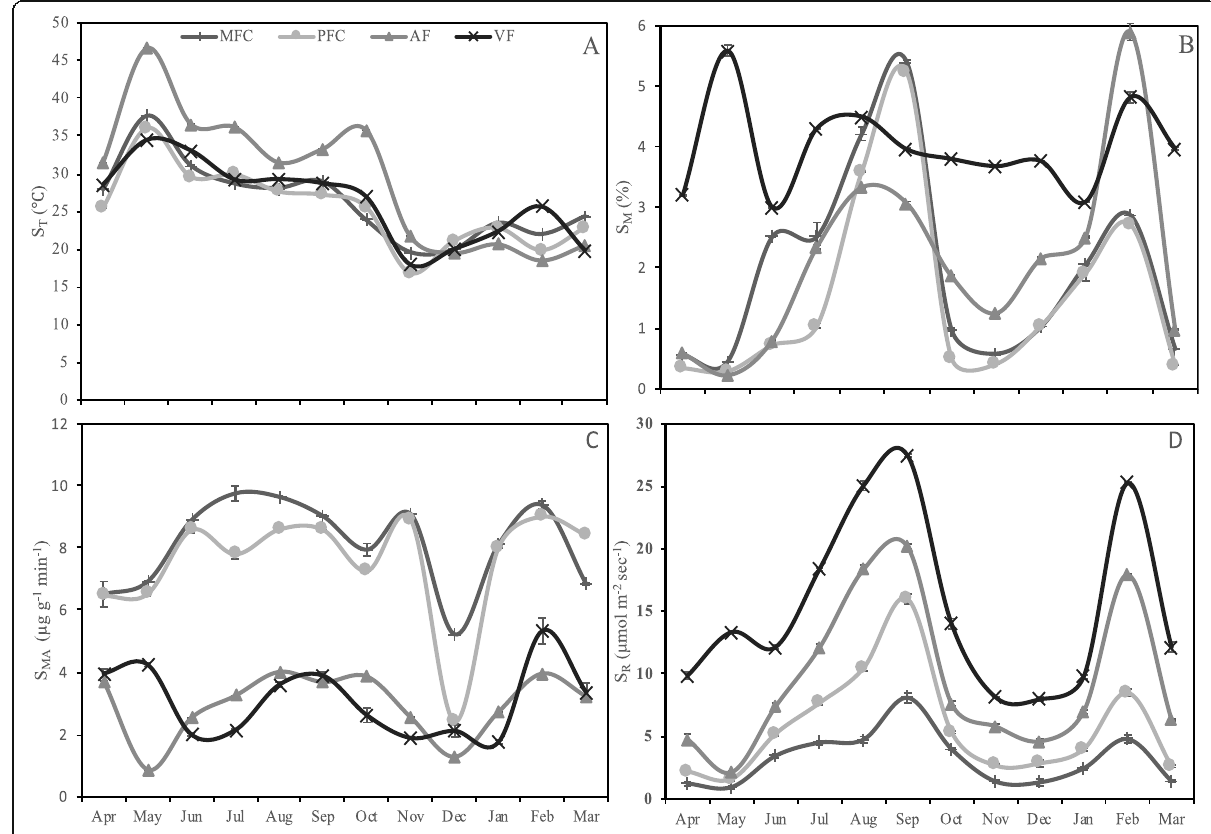
Fig. 4 Seasonal variation of soil respiration (S R ) and environmental factors for the four land uses. Mean monthly S T soil temperature (at 10 cm depth) ( a ), S M soil moisture ( b ), S MA soil microbial activity ( c ), and S R soil respiration ( d ) of PFC Prosopis juliflora forest cover, MFC mixed forest cover, AF agriculture field, and VF vegetable field in a semi-arid area of Delhi. Standard error of each mean is represented over each